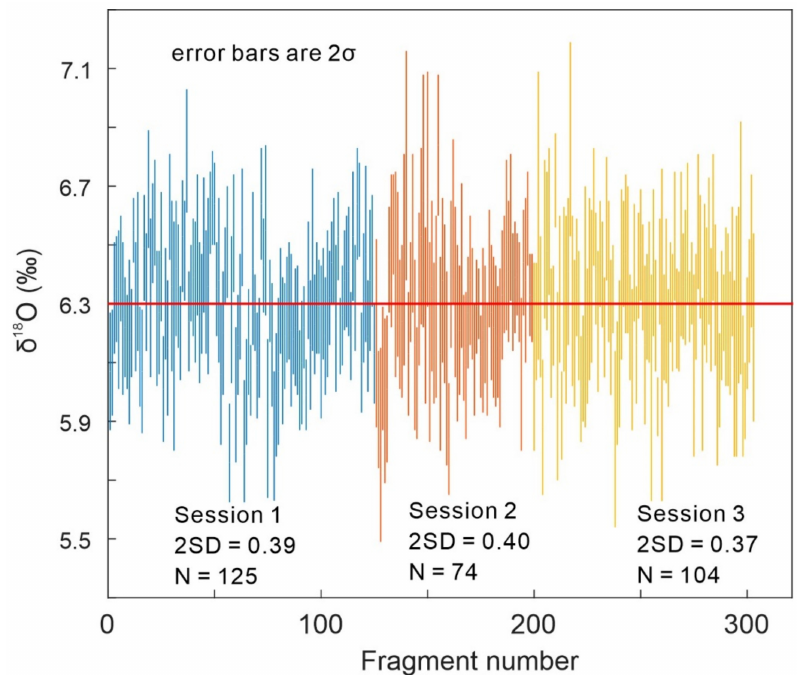
Figure A2. Reproducibility of RW-1 SIMS δ 18 O values with the average value normalized to the LF-IRMS value.